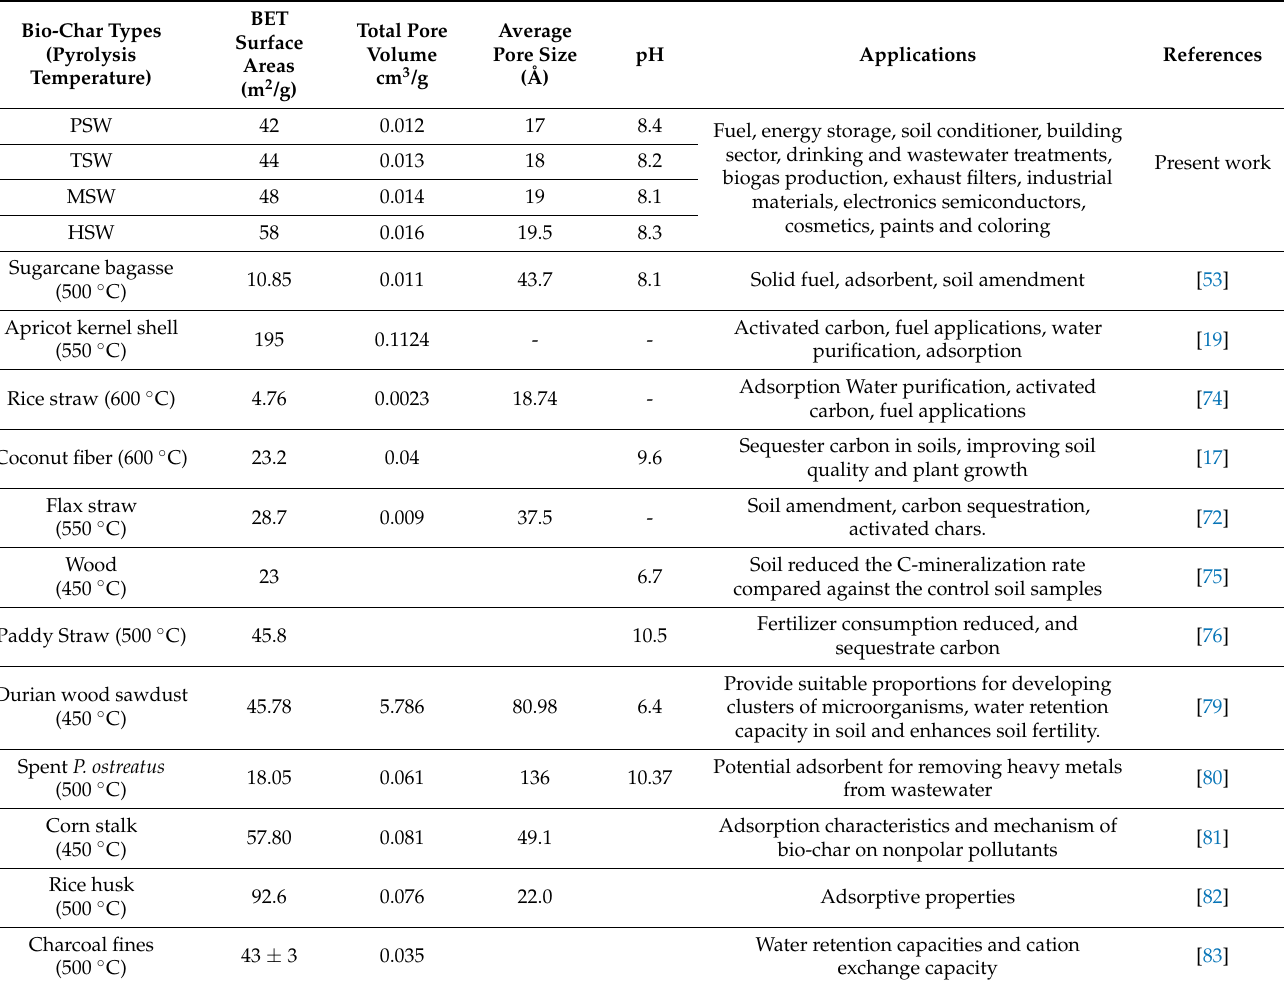
Table 4. Surface area, total pore volume, average pore size volume and pH values of WS bio-chars with different temperatures, at 1.5–2.5 mm particle size and 20 ◦ C/min heating